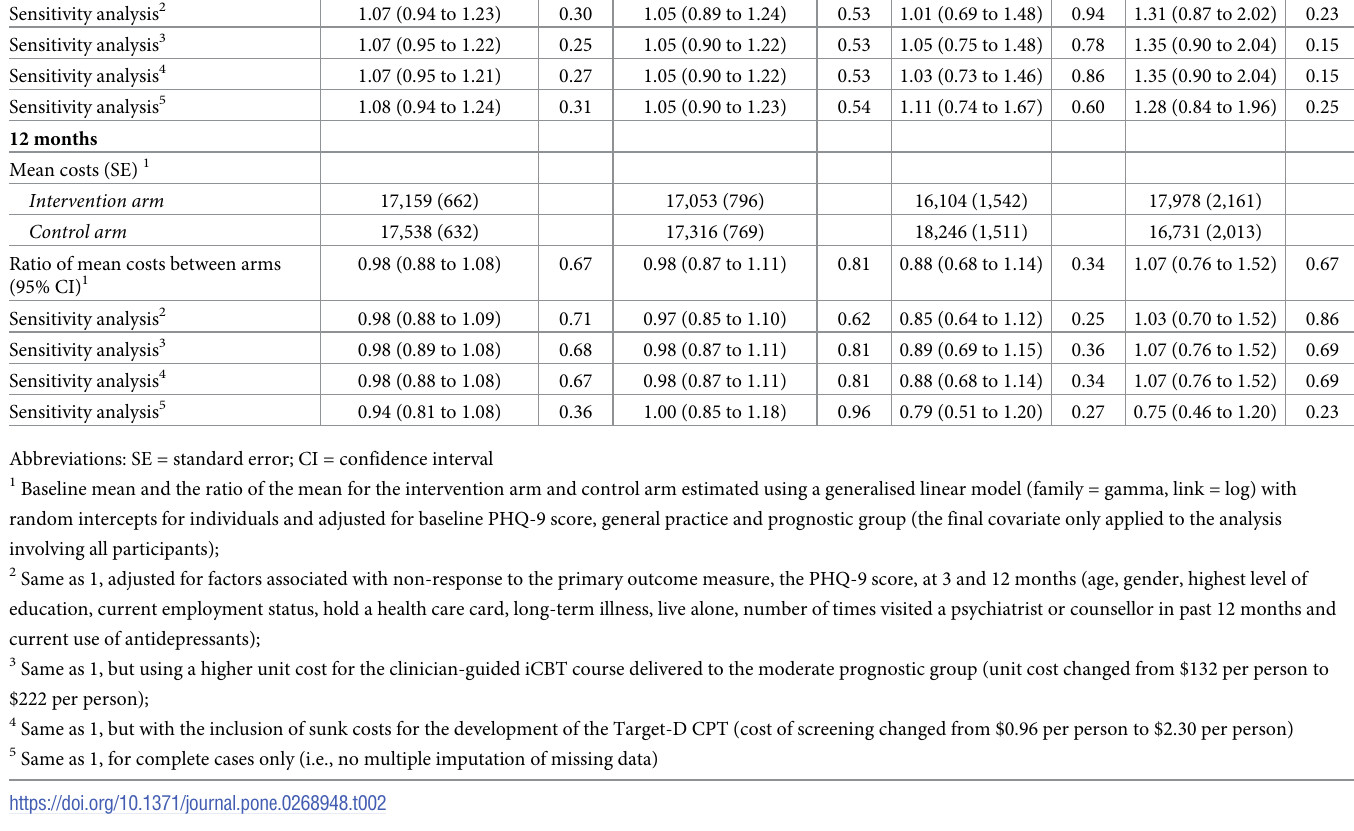
All participants p-value Minimal/mild p-value Moderate p-value Severe (n = 223) (n = 1,868) (n = 1,357) (n = 288)